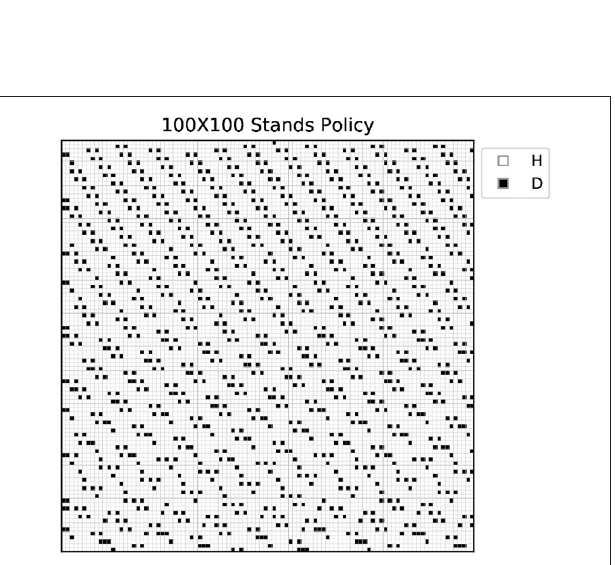
FIGURE 12 | Computed DRL policy for the 100